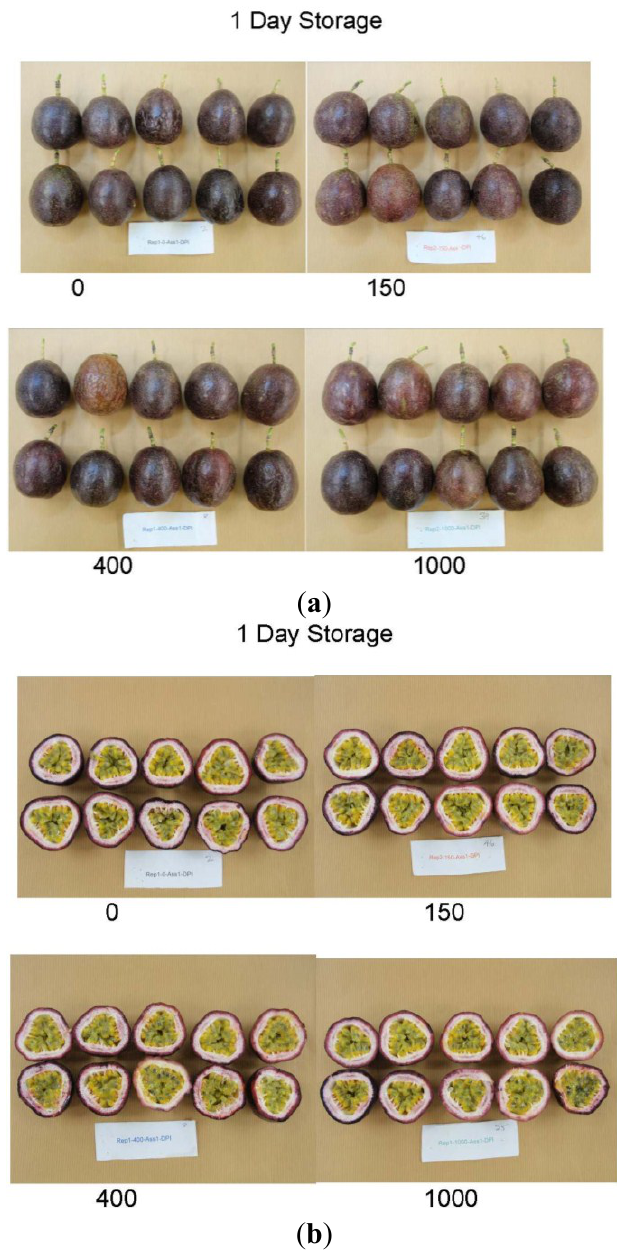
Figure 1. ( a ) Irradiated passionfruit after one day storage at 8 °C. Fruit were treated with 150 Gy (top right), 400 Gy (bottom left) and 1000 Gy (bottom right), or left untreated (0 Gy, top left); ( b ) Irradiated passionfruit after one day storage at 8 °C. Fruit were treated with 150 Gy (top right), 400 Gy (bottom left) and 1000 Gy (bottom right), or left untreated (0 Gy, top